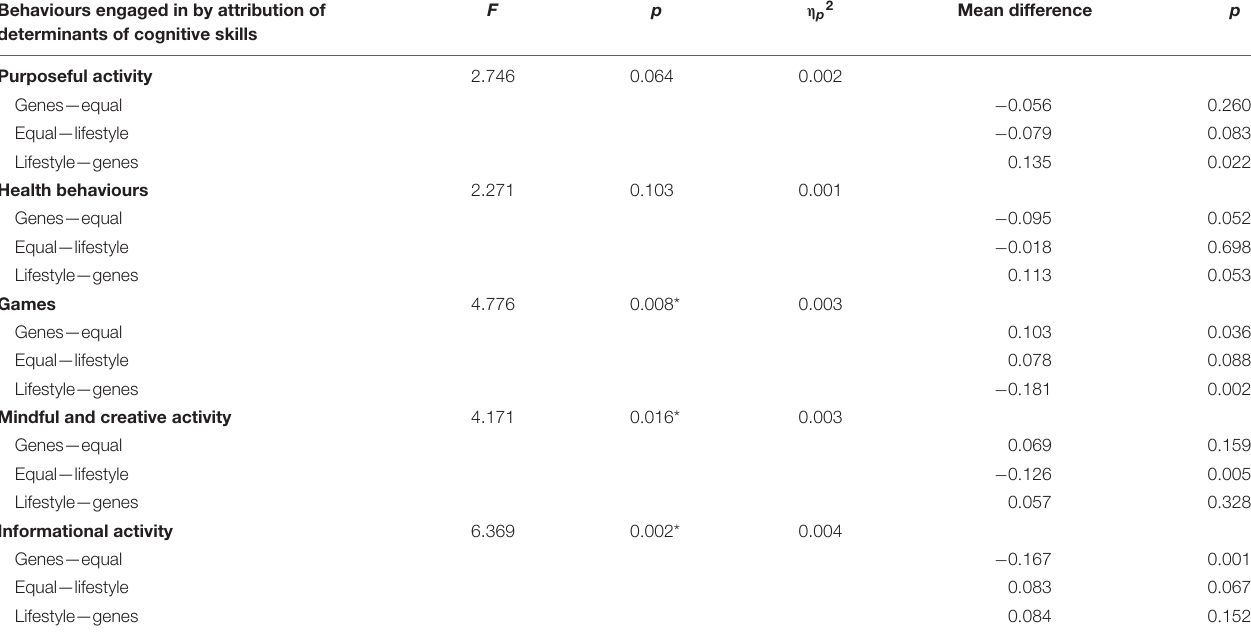
TABLE 3 | ANCOVAs examining respondents’ engagement in behaviours according to their opinions about determinants of cognitive skills. Behaviours engaged in by attribution of F p η p 2 Mean difference p determinants of cognitive skills Purposeful activity